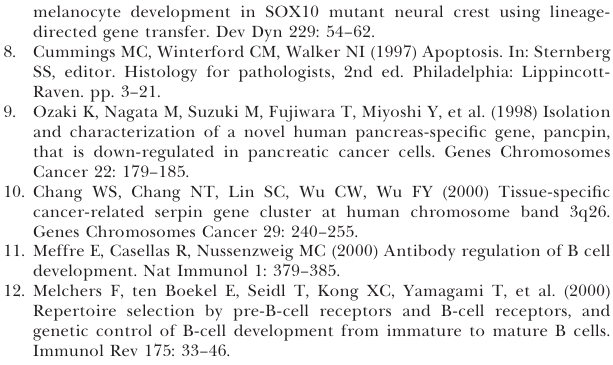
Figure S1. Detection of Neutrophils in the Bone Marrow of Wild- Type and pq/pq Mice (A) Flow cytometric analysis was conducted by gating on granulocytes using forward versus side light scatter and GR-1and CD11b staining in the bone marrow. Increased percentage of neutrophils in the bone marrow of pq/pq mice is due to elevated percentage of GR-1lo CD11b þ immature neutrophils. Table S1. Primers Sets Used to Define Genomic pequen˜o Deletion Table S2. pequen˜o Mice Show Increased Percentage of Neutrophils in